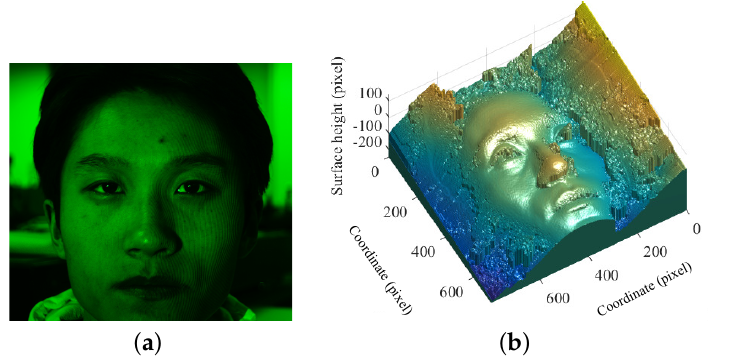
Figure 9. Measurement and reconstruction of a dynamic human face at spatial frequency of 1.0 lp /mm and the background illuminance E = 50 Lux : ( a ) face image with projected fringe pattern; and ( b ) reconstructed face using the measurement of (a).